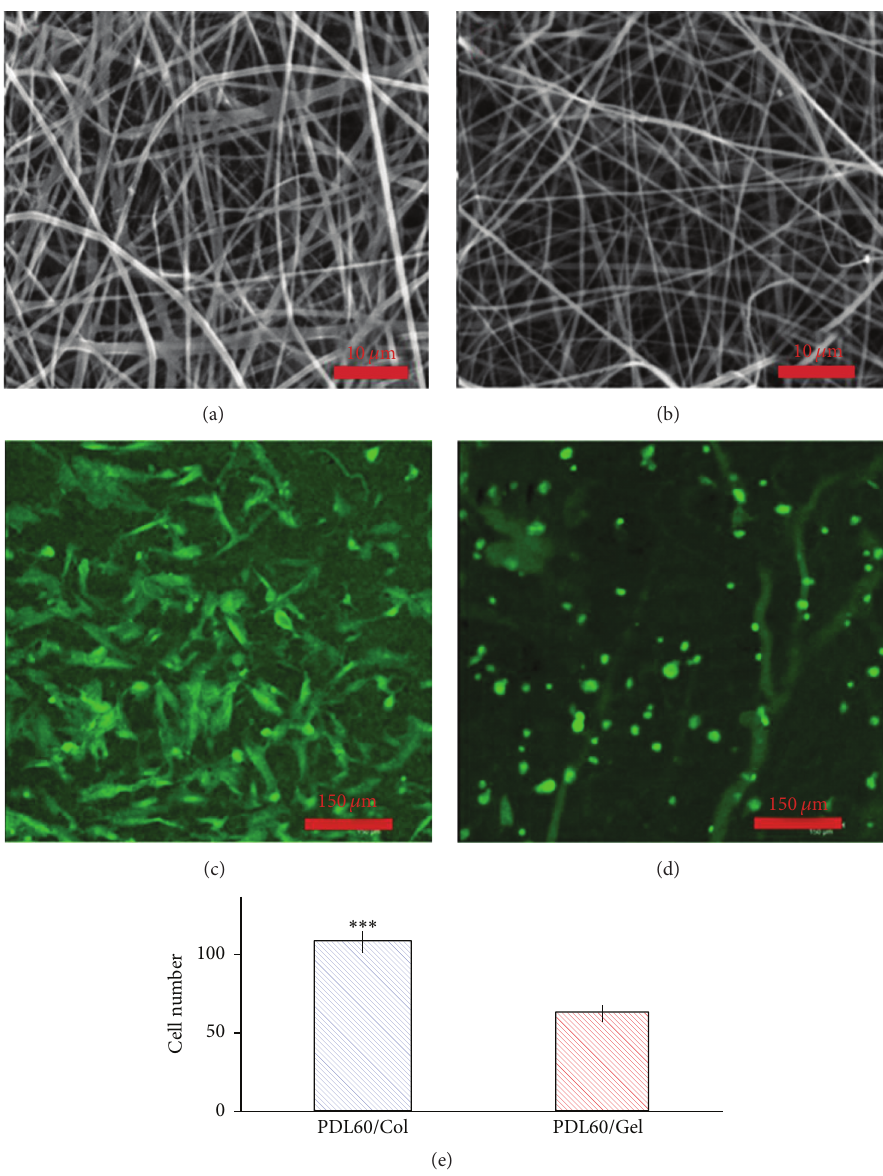
Figure 3: HBMSCs attachment on the PDL60/Col and PDL60/Gel electrospun scaffolds. (a, b) are SEM images of PDL60/Col scaffolds and PDL60/Gel scaffolds, respectively. (c, d) are maximum projection fluorescence images of PDL60/Col and PDL60/Gel cell-scaffold constructs, respectively. (e) Cell numbers were counted based on the confocal images (originally adapted from [69]). ∗∗∗